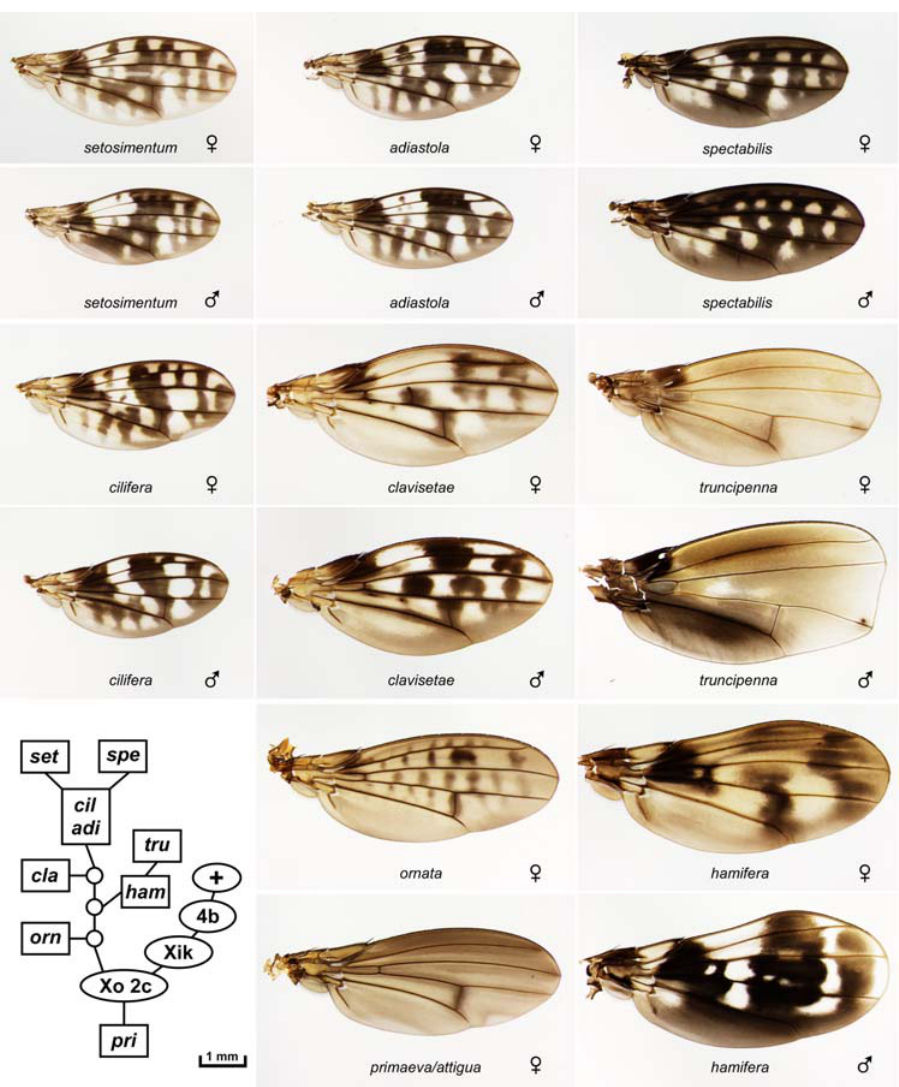
Figure 2. The adiastola and primaeva/attigua subgroups of picture wing species. D. adiastola, cilifera, clavisetae, hamifera, setosimentum, spectabilis , and truncipenna are shown as sexually dimorphic pairs, ornata and primaeva / attigua as single examples. In all figures, anterior is up and proximal is to the left. Inset, chromosome inversion-based lineage for the species shown (see text).